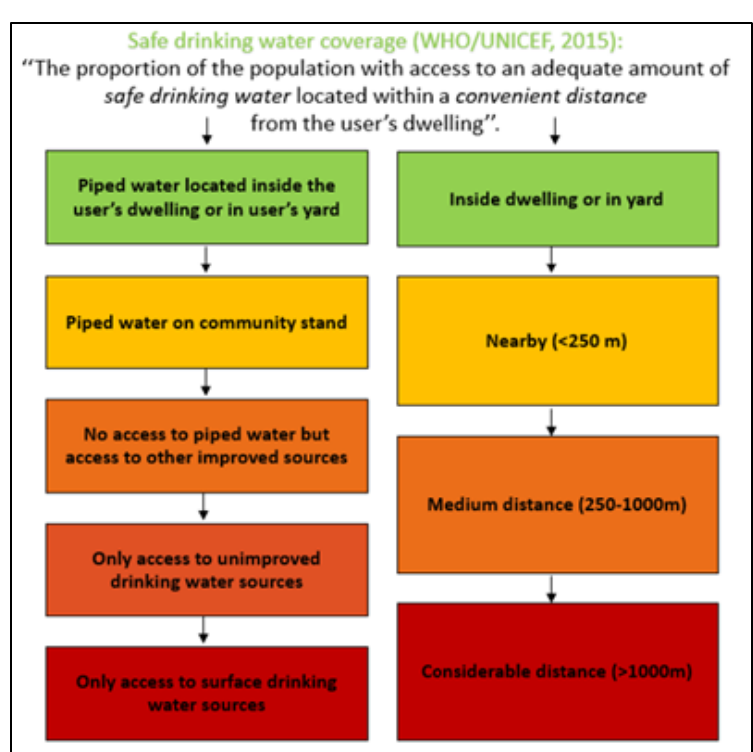
Figure 1. Safety and proximity of drinking water sources [9,34,35].